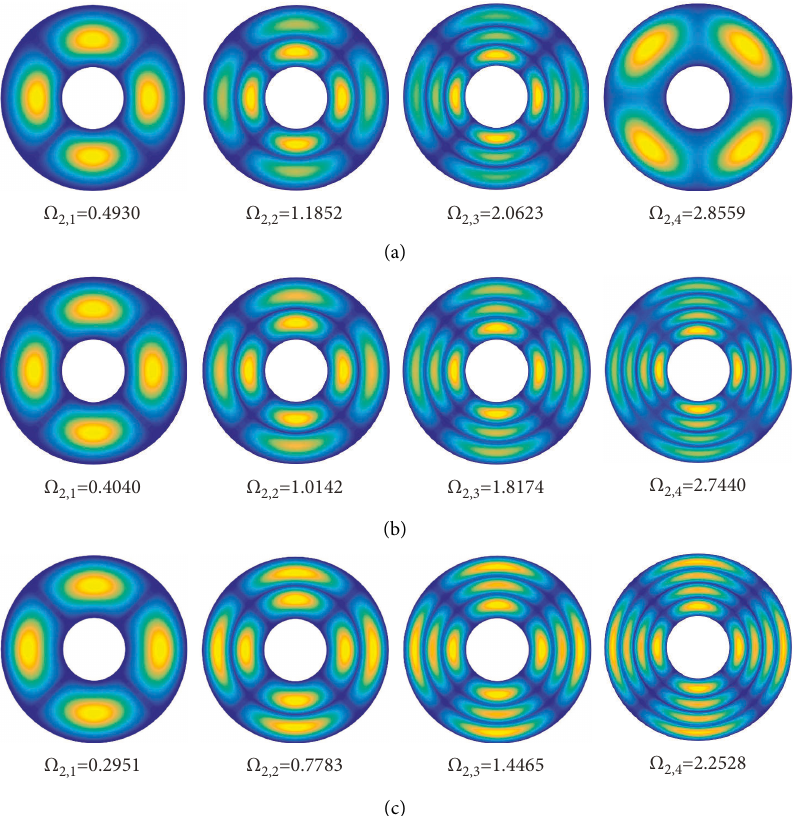
Figure 12: Mode shapes of laminated composite annular plate with variable thickness, (a) α � − 0.5, (b) α � 0, and (c) α �